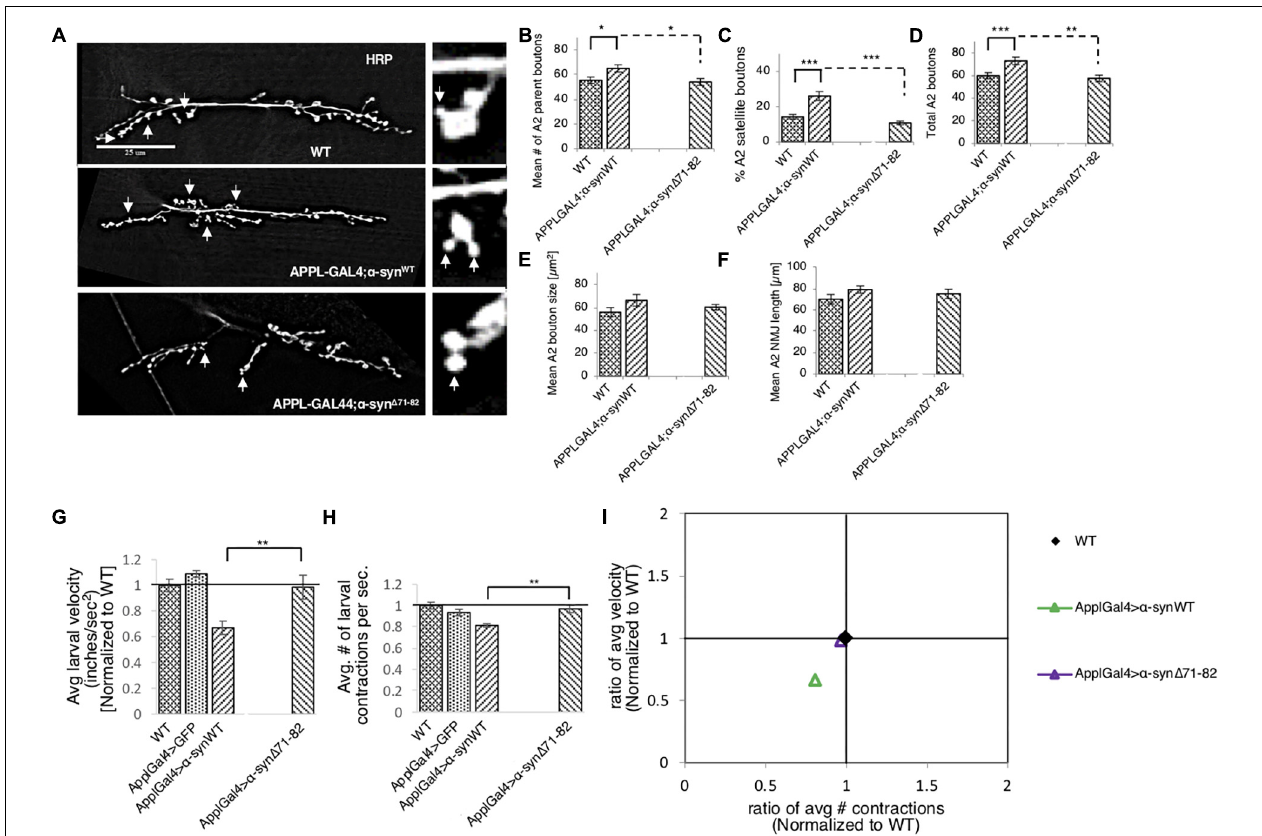
FIGURE 5 | Deletion of the NAC region rescues α -syn-mediated synaptic morphological defects and larval locomotion defects. (A) Larval segment A2 of muscle 6/7 from wild-type (WT), α -syn WT , or α -syn (cid:49) 71 − 82 stained with the pre-synaptic marker horseradish peroxidase (HRP). Inset of enlarged images shows a single synaptic bouton with satellite boutons budding off (arrows). (B) Quantitative analysis of the mean number of parent bouton in α -syn (cid:49) 71 − 82 expressing larvae shows a significant decrease ( p < 0.05) compared to α -syn WT . Note that α -syn (cid:49) 71 − 82 is comparable to WT. (C) Quantitative analysis of the percent (%) of satellite boutons in α -syn (cid:49) 71 − 82 larvae shows a significant decrease compared to α -syn (cid:49) 71 − 82 ( p < 0.001) similar to WT. (D) Quantification of the total number of boutons, which include both parent and satellite boutons, shows a significant decrease in α -syn (cid:49) 71 − 82 ( p < 0.01) compared to α -syn (cid:49) 71 − 82 and similar to WT. (E) Mean bouton area and (F) NMJs length from α -syn WT or α -syn (cid:49) 71 − 82 show no differences compared to the WT control. Quantitative analysis represents mean ± SEM. ∗ p < 0.05, ∗∗ p < 0.01, ∗∗∗ p < 0.001, n = 15. Bar = 25 µ m. (G) Quantification of the average crawling velocity (normalized to WT) for larvae expressing α -syn WT or α -syn (cid:49) 71 − 82 compared to WT. The average velocity of larvae expressing α -syn (cid:49) 71 − 82 was significantly increased compared to α -syn WT larvae ( p < 0.01) and was comparable to WT. (H) Quantitative analysis of the average number (#) of contractions in 60 s (normalized to WT) for larvae expressing α -syn (cid:49) 71 − 82 indicates a significant increase in contractions compared to α -syn WT ( p < 0.01) and was similar to WT. (I) The ratio of the average contractions ( X -axis) plotted against the ratio of the average velocities ( Y -axis) (WT normalized to 1) for α - α -syn WT and α -syn (cid:49) 71 − 82 expressing larvae. Note that α -syn (cid:49) 71 − 82 larvae are similar to WT larvae and distinct from α -syn WT larvae. Quantitative analysis represents the mean ± SEM. ∗∗ p < 0.01, n =